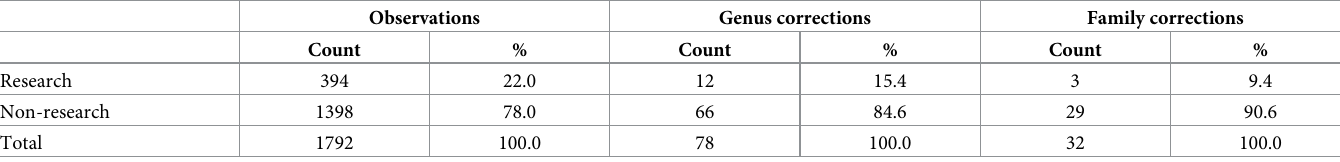
Table 4. Number of genus and family corrections for research grade and non-research grade observations based on a sample of 1792 species and genus records in the